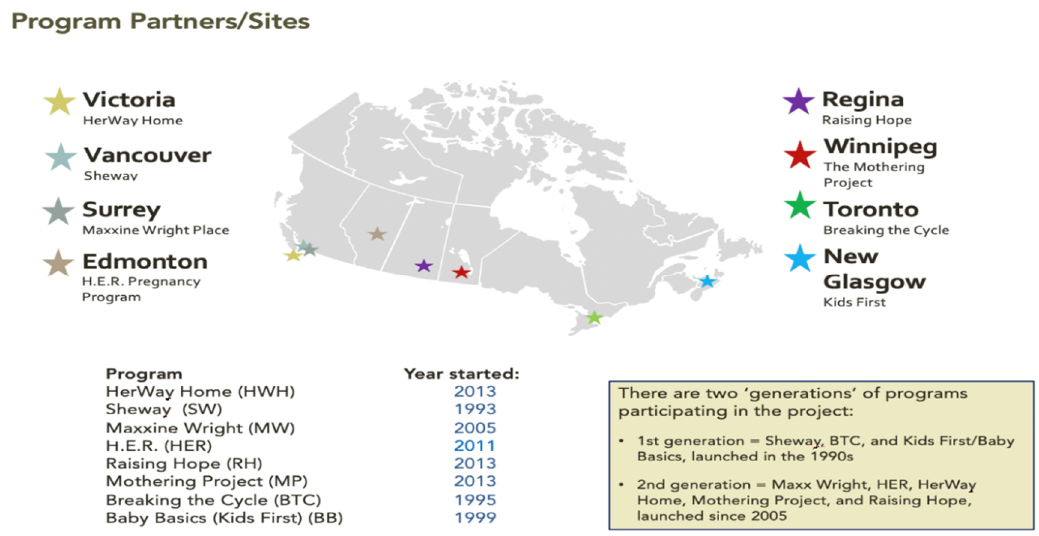
Figure 1. The Co-Creating Evidence project program partners.